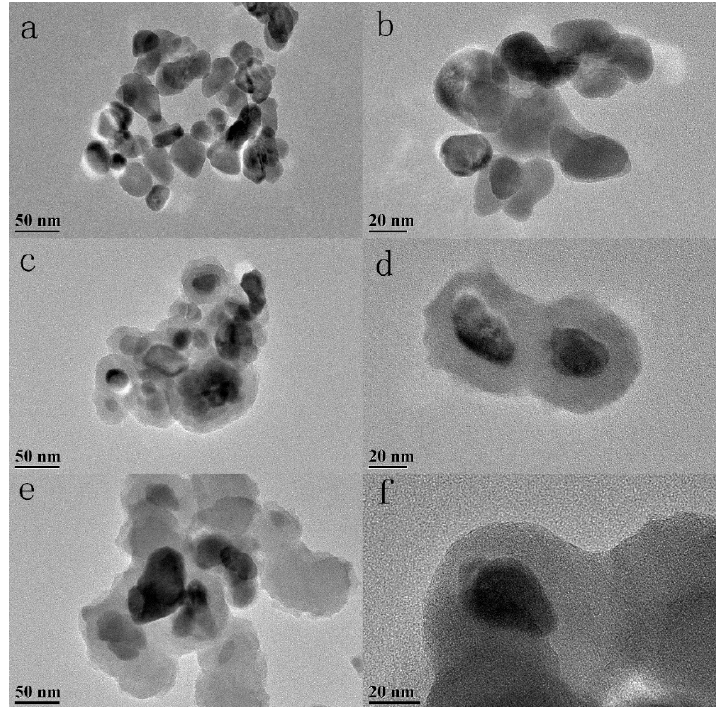
Figure 3. Transmission electron microscopy (TEM) images of ( a,b ) ZnO, ( c,d ) PDA/ZnO, and ( e,f ) DMSA/PDA/ZnO.